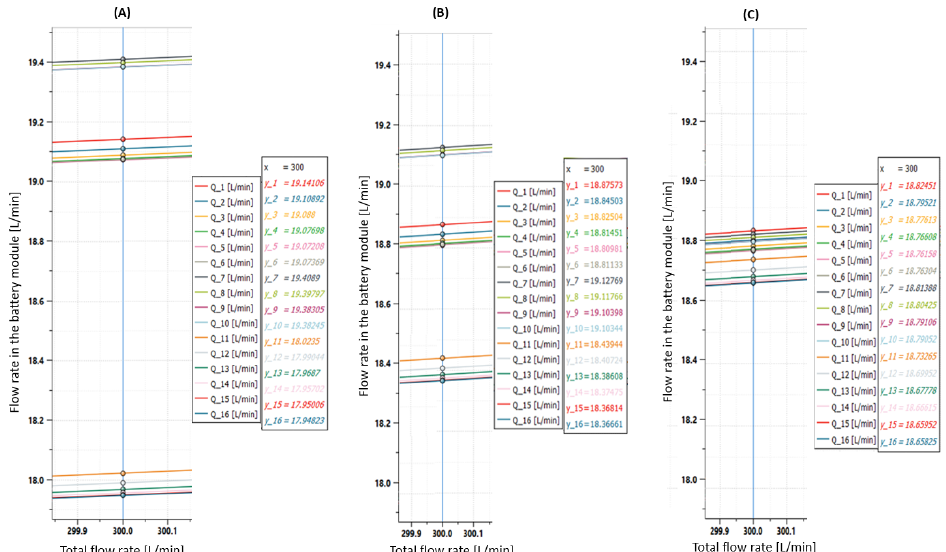
Figure 13. ( A ) Flow rates without calibrated orifices. ( B ) Flow rates with 10 mm orifice in the first and second branches. ( C ) Flow rates with 9 mm orifice in the first branch and 8.5 mm orifice in the second